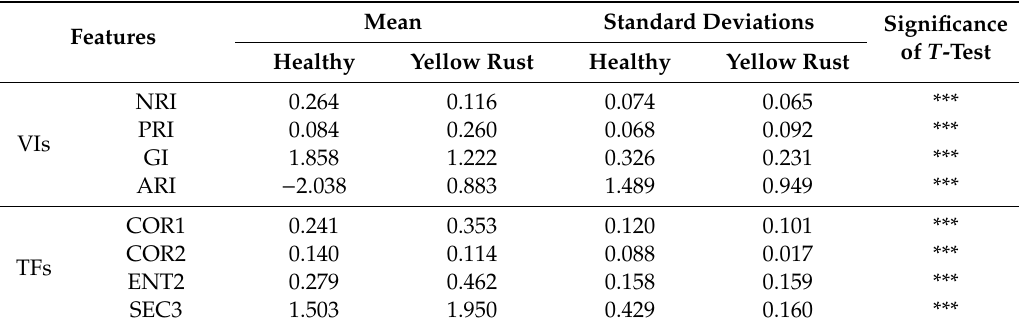
Table 4. Summary statistics of VIs and TFs selected by the correlation-based feature selection